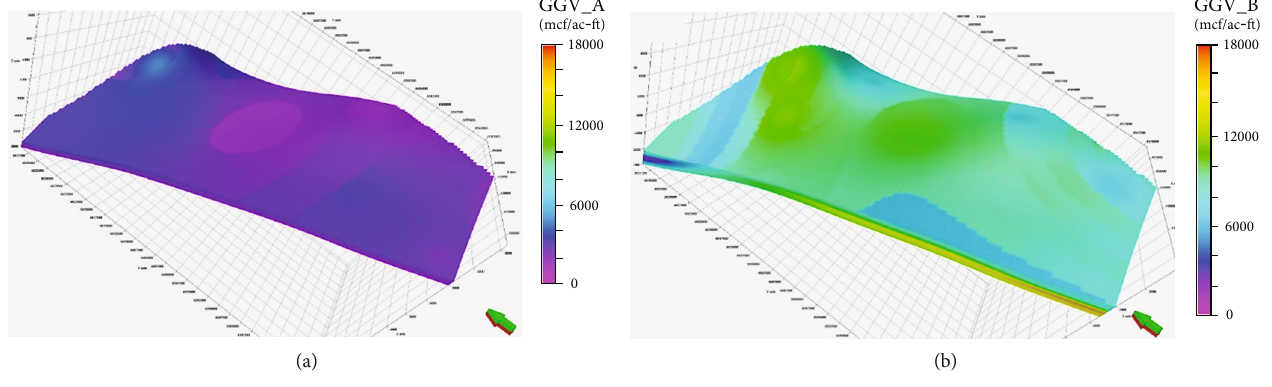
Figure 12: 3D distribution of generated gas volume (GGV) in the A shale bed (a) and the B shale bed (b) in the study area ( × 20 vertical exaggeration). Estimated generated gas volume in the A shale bed and B shale bed shows a range from approximately 2,000 to 3,000 and a range from 8,000 to 14,000 mcf/ac-ft (million cubic feet per